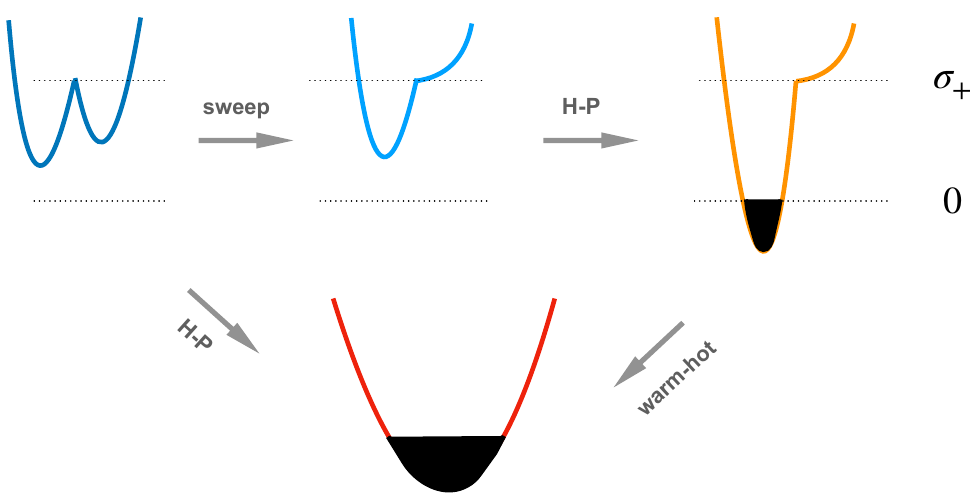
Figure 7 . Curves of the blueshift factor g tt as one traverses space along the Z 2 symmetry axis. The color code is the same as in figure 6. The wall is located at the turning point g the curve is discontinuous. The grey arrows indicate possible transitions. The blackened parts of the curves are regions behind the